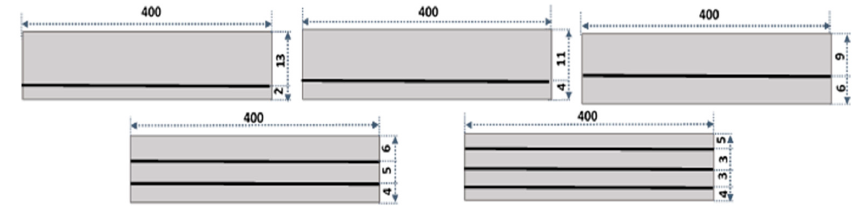
Figure 2. Schematic drawing for the arrangement of carbon textile in the specimens (unit: mm).